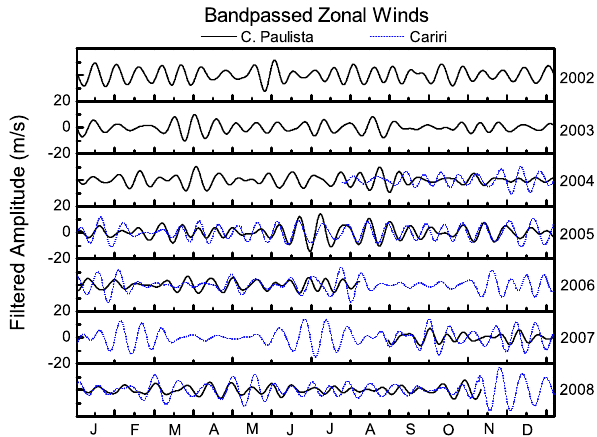
Fig.9. BandpassedhourlyzonalwindsoverCariri(bluedot),fortheyears2004to2008,and to 2008, at 90 km. The pass-band limits used was 8 to 24 days, centered on 16 days.